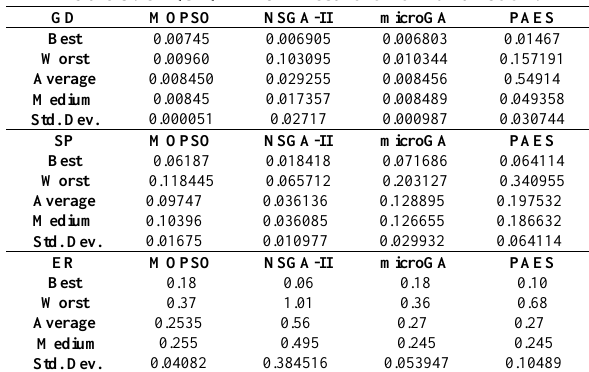
Table 3: GD/SP/ERROR result for third function. GD MOPSO